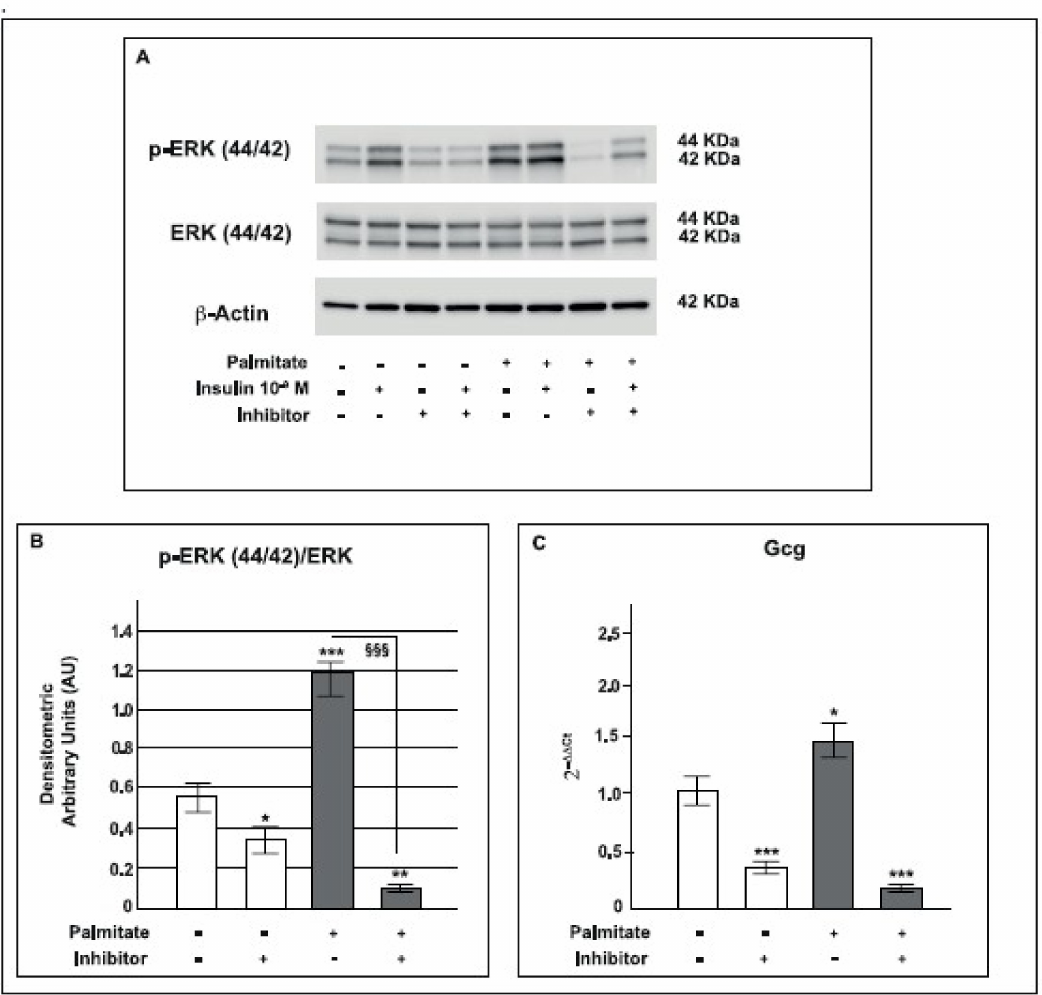
Figure 8. Effect of MAPK pathway inhibition on proglucagon gene expression in GLUTag cells pre-exposed to palmitate. A : representative Western blot for p-ERK 44/42, ERK 44/42 and β -actin from control and palmitate GLUTag treated cells (0.5 mM for 24 h) in the absence or presence of the U0126 (MAPK Inhibitor). B : corresponding densitometric analysis in control cells (open bars) and in cells exposed to palmitate (gray bars). * p < 0.05, ** p < 0.01, *** p < 0.001 vs. control; §§§ p < 0.001 vs. palmitate (1-way ANOVA followed by Bonferroni test, n = 3). C : Box plot of proglucagon ( GcG ) mRNA expression in control cells (open bars) and in 0.5 mM palmitate treated cells for 24 h (gray bars) in the absence or presence of U0126. Values on the y-axis are reported as 2 − ∆∆ C t . Statistical significance was evaluated by t -test ( n = 3, * p < 0.05, *** p < 0.001 vs. control); (+) means presence, (-) means